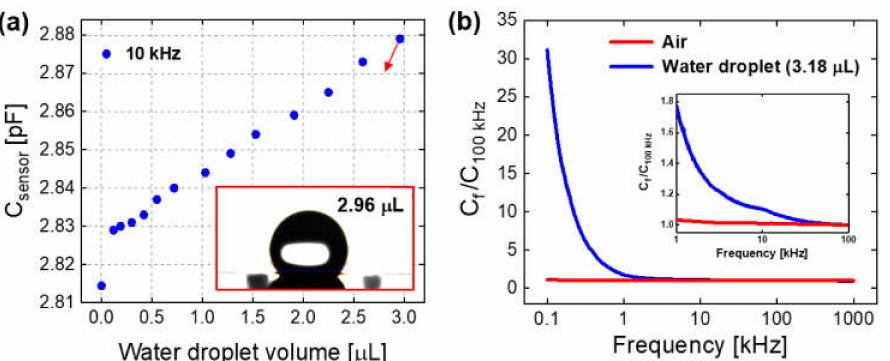
Figure 6. For the SAM-coated sensor with or without a water microdroplet on the top surface: ( a ) the sensor capacitance at 10 kHz with the water droplet volume (inset: optical microscope image of a 2.96-microliter droplet on the top surface of IDE patterned substrate) and ( b ) the capacitance ratio (sensor capacitance at a frequency to that at 100 kHz) with the operating frequency in the range of 0.1–1000 kHz (inset: the enlarged graph in the range of 1–100